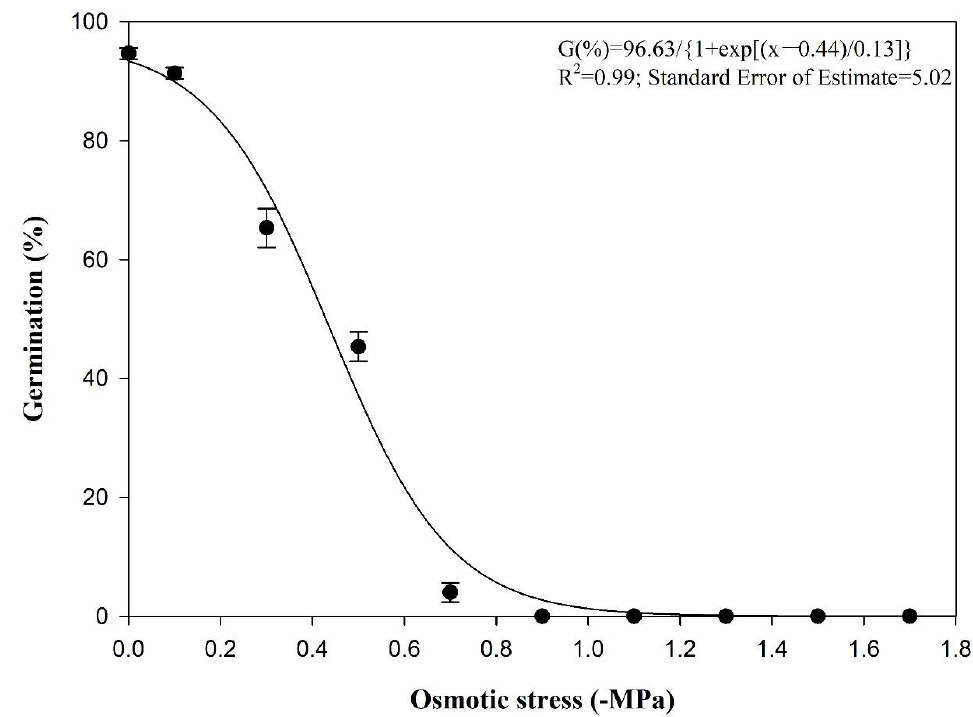
Figure 2. Effect of osmotic stress on the germination of Vicia villosa seeds incubated at 20 °C under a 12/12-h dark/light photoperiod for 21 d. The vertical bars represent the standard error of the means.